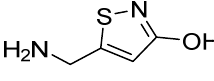
Figure 3. Structure of GABA and β -alanine analogues tested against TauT. Their biological activity was determined by [ 3 H]-taurine uptake using SKPT cells and expressed as IC 50 values. Compounds are sorted according to the increasing IC 50 values [67].